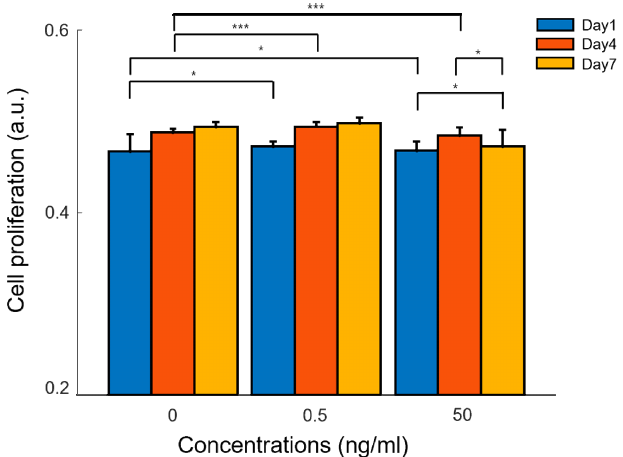
Figure 7. Cellular proliferation in three-dimensional GelMA-based hydrogels with different concentrations of astaxanthin (0, 0.5, and 50 ng/ml) on day 1, 4, and 7. Data are presented as the mean ± standard deviation (n = 4). (*** p < 0.001, * p < 0.05).